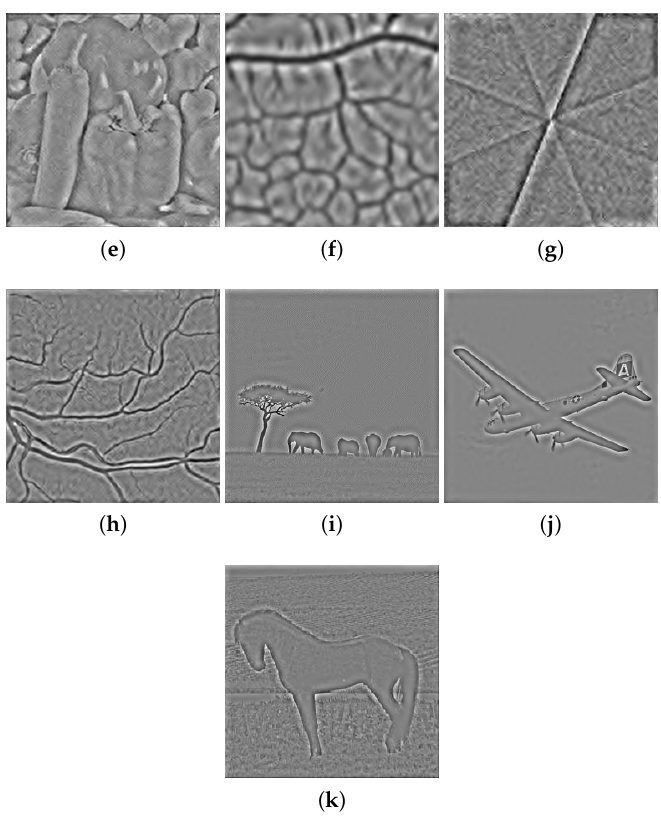
Figure A4. Edge information used in the fidelity term for ( a ) the ‘Peppers’ image with added noise, SNR = 15 dB ( b ) ‘Leaf’, ( c ) the ‘Sectors’ image with added noise, SNR = 10 dB, ( d ) retinal image, ( e ) ‘Elephants’, ( f ) ‘Plane’, ( g )